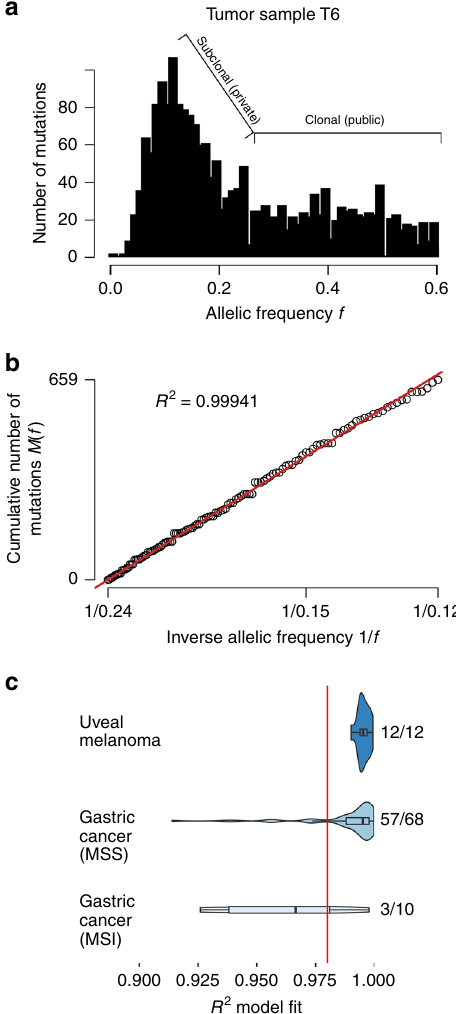
Fig. 5 Analysis of uveal melanoma whole genome sequencing (WGS) data for evidence of neutral tumor evolution. a Histogram of mutant allele frequency for representative tumor sample T6. Mutations that occur at frequencies ≥ 0.25 are considered to be clonal (public) and those occurring at frequencies below this cutoff are subclonal (private) 14 . b Cumulative distribution, M ( f ), of subclonal mutations for sample T6, which is highly consistent with the neutral evolution model 14 . c Comparison of goodness- of- fi t, R 2 , for neutral tumor evolution in uveal melanoma versus previously published gastric cancer WGS data 14 . All 12 uveal melanoma samples demonstrated R 2 ≥ 0.98 (red line), whereas 60 of 78 (76.9%) gastric cancer samples without microsatellite instability (MSS) and only 3/10 (30%) of gastric cancer samples with microsatellite instability (MSS) met this threshold. The proportion of samples with a particular R 2 model fi t is proportional to the violin plot width. Box plots within the violin plot illustrate the median, upper, and lower quartiles, and Tukey's whiskers (median